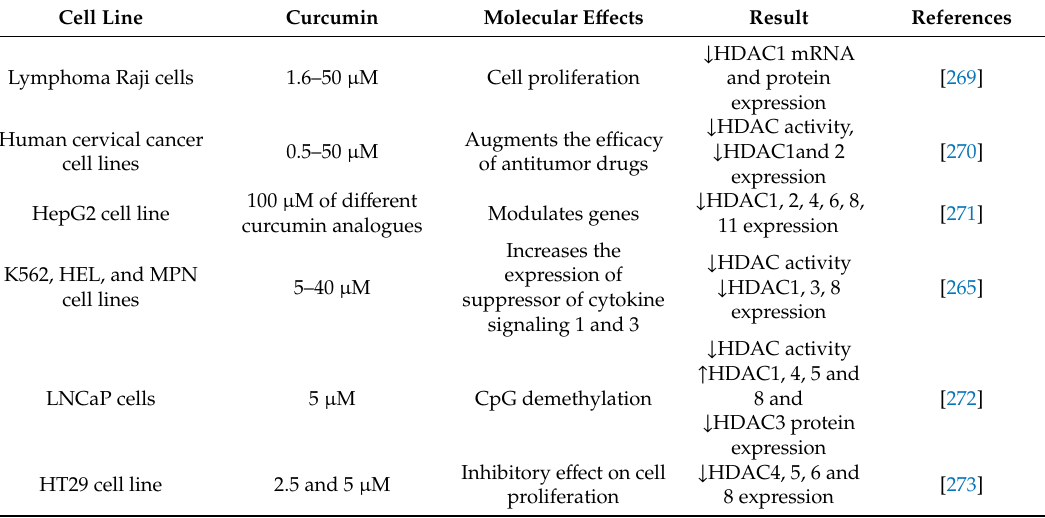
Table 2. In vitro studies on the effects of curcumin on histone deacetylases (HDACs).